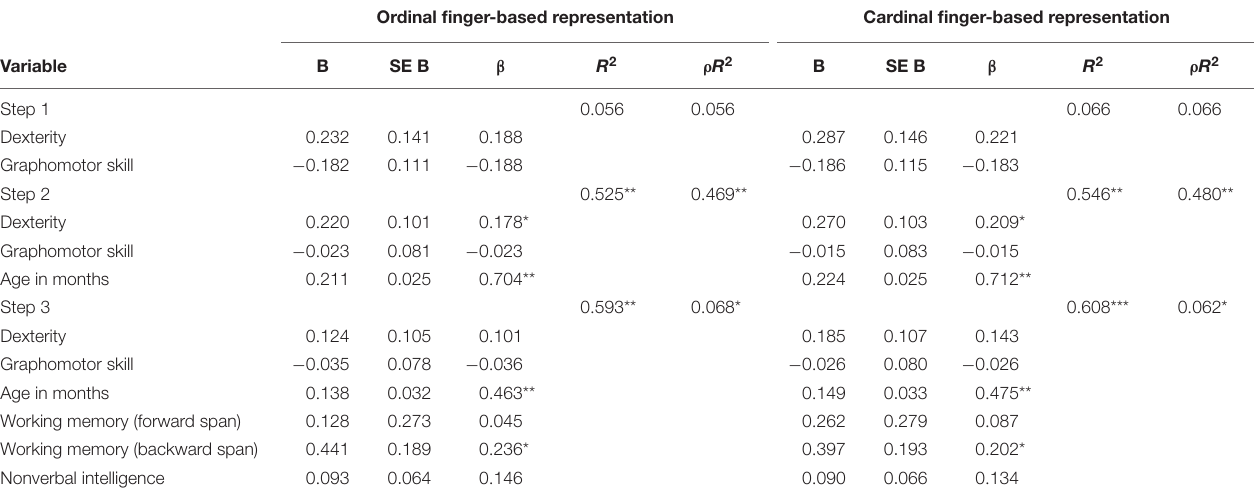
TABLE 3 | Hierarchical linear regression models predicting ordinal and cardinal finger-based representations. Ordinal finger-based representation Cardinal finger-based representation